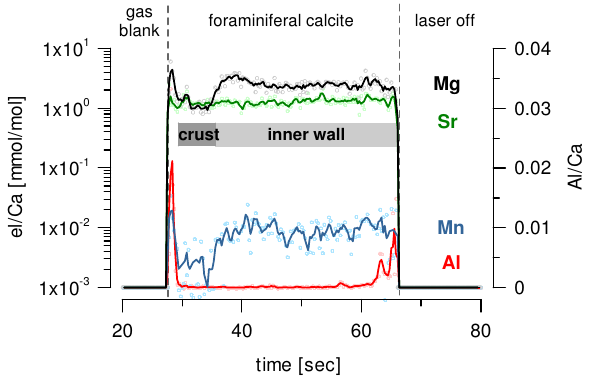
Fig. 3. Element/Ca ratios through chamber F-2 of N. dutertrei from the Mozambique Channel sediment trap. Thick lines represent 3- point running means. The double layering is highlighted with grey bars. The high values at the beginning of the ablation profiles are ignored in the analyses. The Al/Ca shows presence of a sediment infill of the test; this part of the profile is therefore not taken into ac- count when calculating the average values (despite the limited effect of the infill on other element/Ca ratios). As Al cannot be quantified absolutely, Al/Ca ratios are expressed as raw counts and therefore unit less.